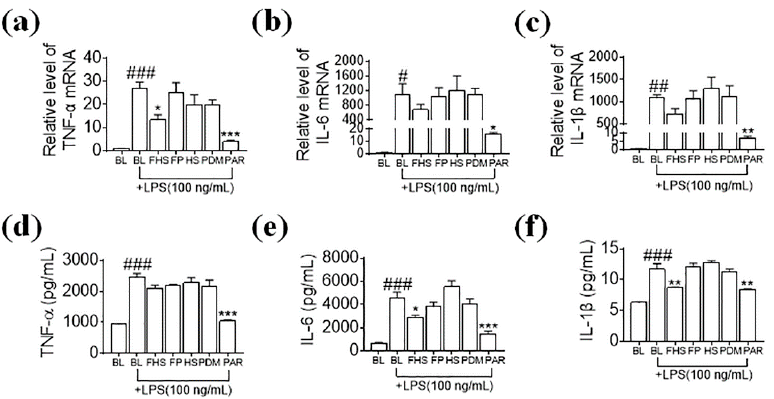
Figure 3. Effects of FHS on mRNA and protein expression of pro-inflammatory cytokines. ( a – c ) The pro-inflammatory cytokines expression on mRNA level was identified by RT-PCR analysis ( n = 3). Cells were treated with FHS, FP, HS, and PDM for 1 h, and then cultured with LPS for another 4 h. ( d – f ) The protein expression of pro-inflammatory cytokines were detected by ELISA kits ( n = 3). Cells were treated with FHS, FP, HS, and PDM for 1 h, and then cultured with LPS for another 24 h. BL, medium without the addition of extracts; FHS, fermented hemp seed-containing medium’s supernatant of Day 7; FP, fermented regular PDB medium’s supernatant of Day 7; HS, unfermented hemp seed-containing medium’s supernatant; PDM, unfermented regular PDB medium’s supernatant. # p < 0.05, ## p < 0.01, ### p < 0.001 vs. the control group; * p < 0.05, ** p < 0.01, *** p < 0.001 vs. the LPS-treated group.